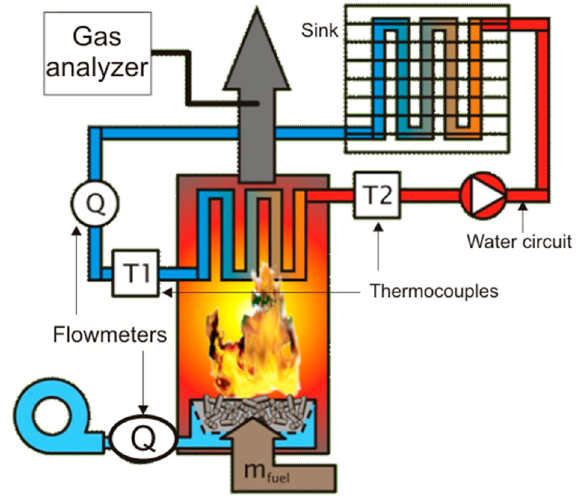
Figure 5. Schematic of the experimental setup.